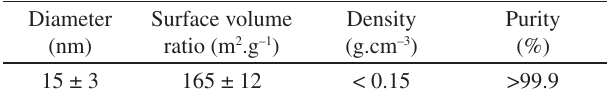
nanoparticles. 2